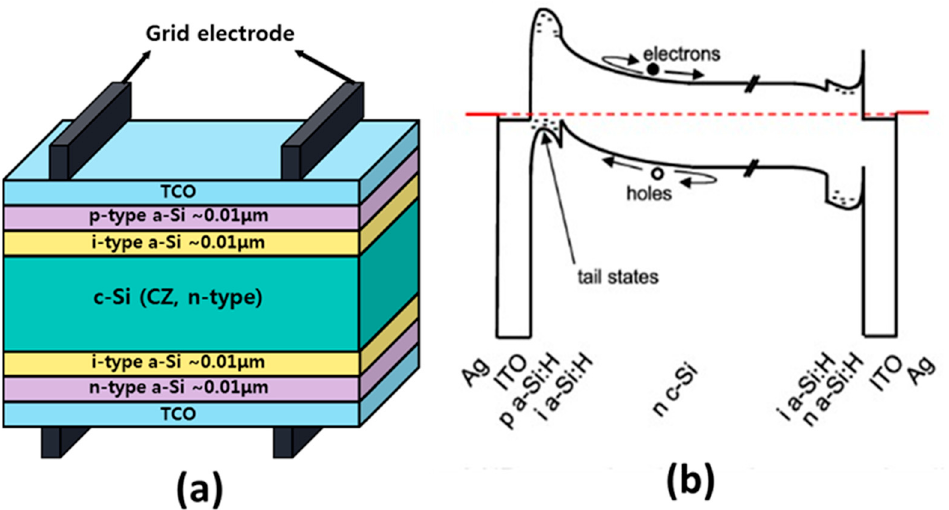
Figure 1. ( a ) Structure of an SHJ solar cell (reprinted with permission from ref. [61], copyright form Elsevier order number 5492900736345); ( b ) energy band diagram for an SHJ solar cell (reprinted